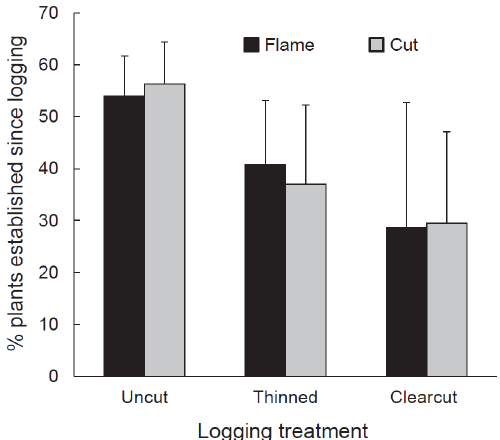
Figure 5. Percent of glossy buckthorn individuals on subplots with buckthorn cut or flamed that established in 2010 or later. Percent of individuals establishing is shown in relation to logging treatment (uncut control, thinned, clearcut). Data collected at MacDonald Lot, Durham, NH, USA, in 2013, the fourth year after logging. n = 16 subplots.